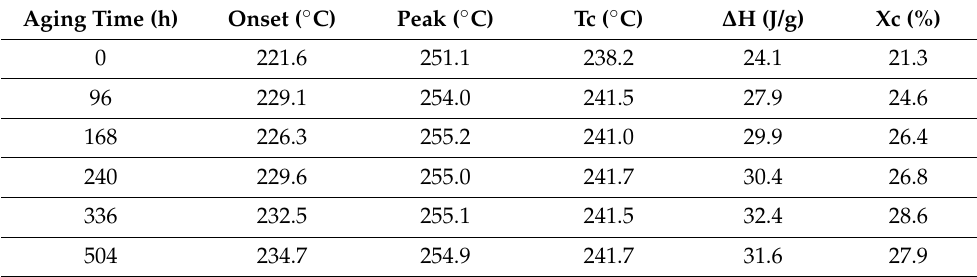
Table 2. Non-isothermal DSC scan results for the samples irradiated at 180 kGy at various aging times. Aging Time (h) Onset ( ◦